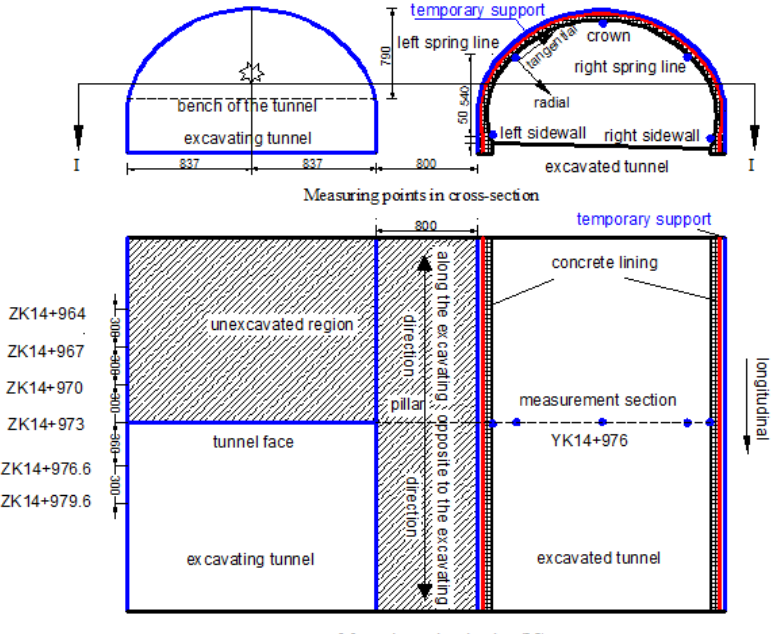
Figure 6. Locations of measuring points (unit:cm).